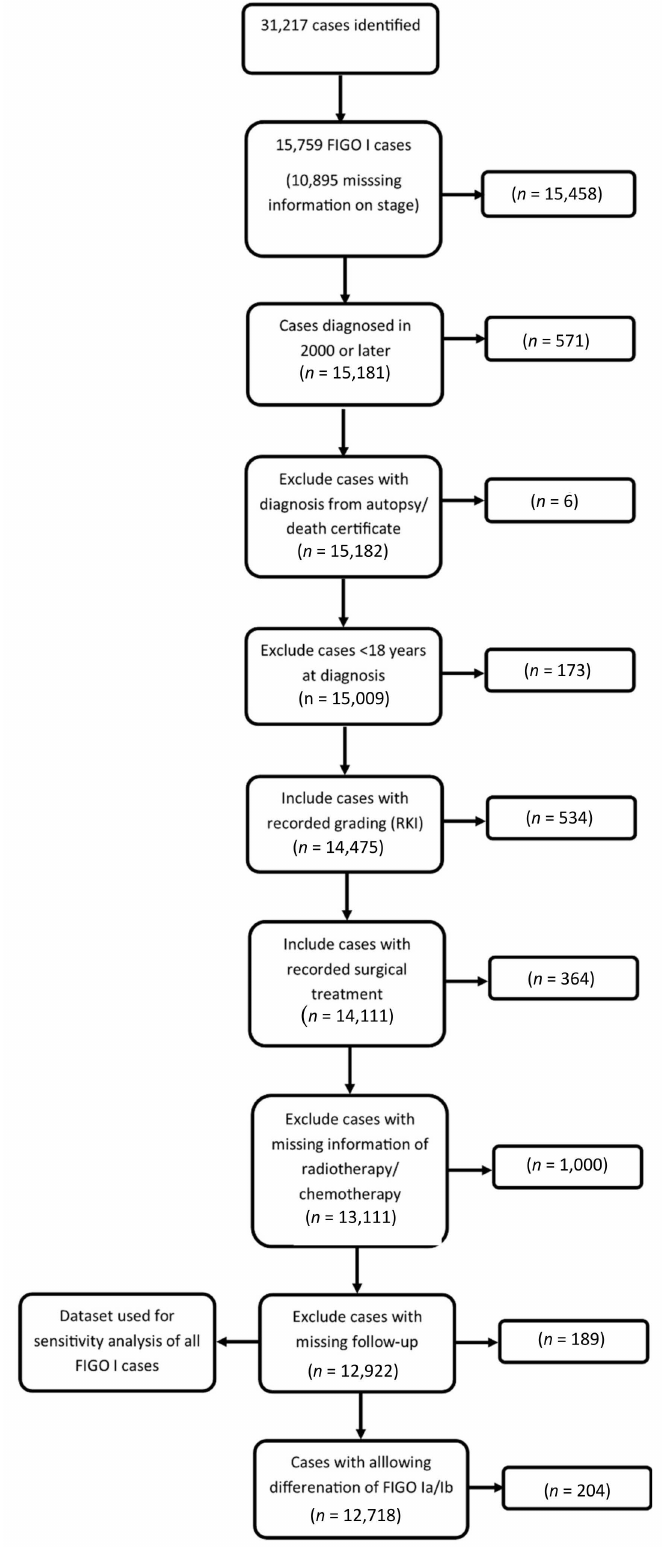
Figure 5. Flow chart of the inclusion / exclusion